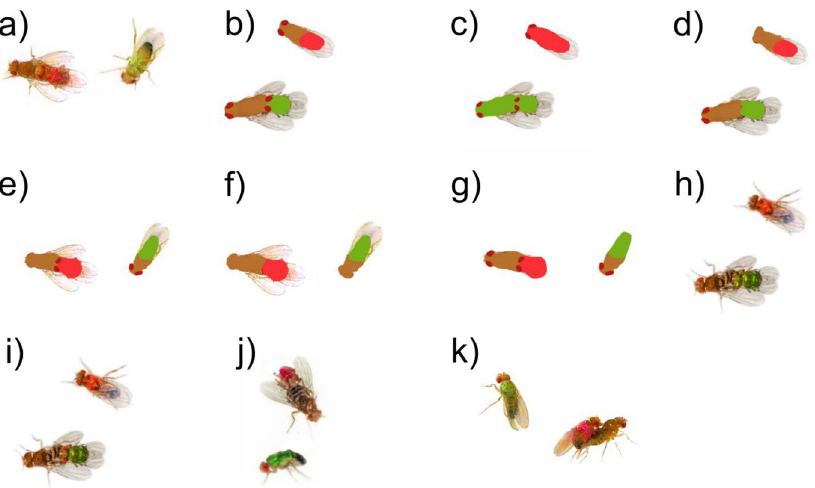
Figure 2. Examples of images used during the demonstration in the various experiments. Here we present only one example per type of treatment, but every treatment included a mixture of top and lateral views of the copulating pairs. ( a ) Unmodified photo where only the background was removed and the colours were made brighter; ( b ) a "dots" demonstration, i.e. pink or green area (or dot) on the back of the males; ( c ) a "painted" demonstration, i.e ., the whole male and whole couple were coloured in pink or green; ( d ) dots but in which males eyes were removed; ( e ) dots in which female eyes were removed; ( f ) dots in which we removed the eyes of all flies; ( g ) dots in which we removed the wings of all flies; ( h ) photo in which we removed the eyes of males; ( i ) photo in which we removed the eyes of the female; ( j ) photo in which we removed the wings of males; ( k ) photo in which we removed the wings of